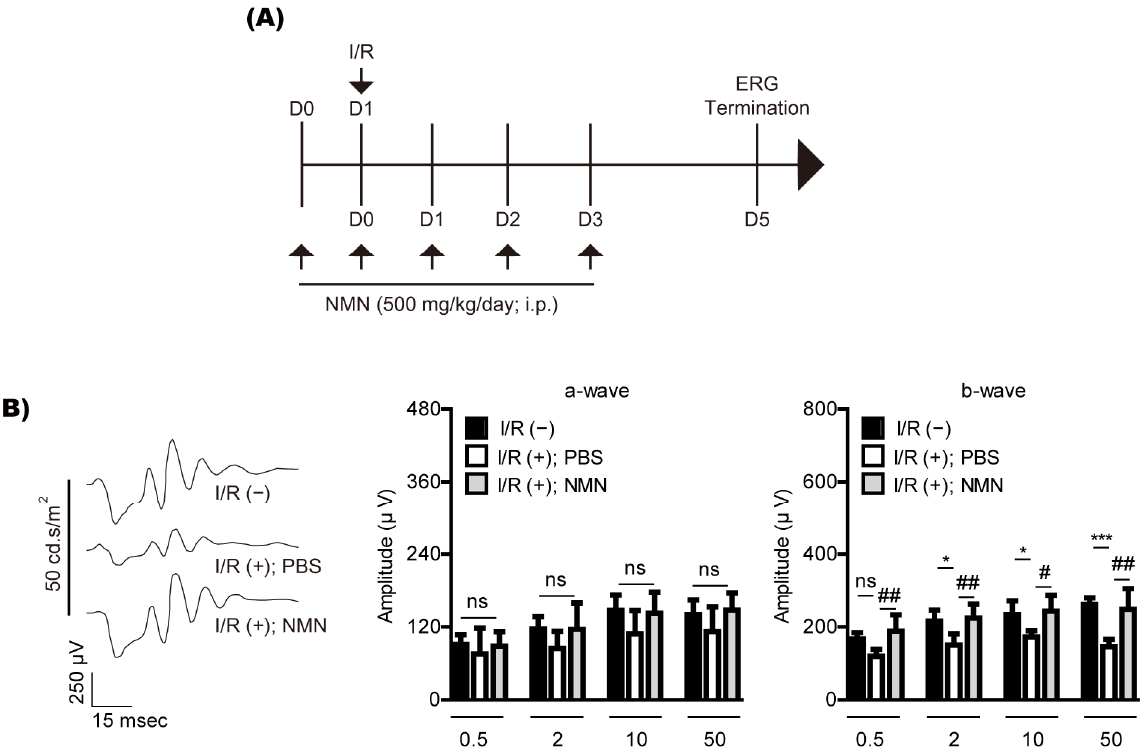
Figure 1. Retinal functional changes by nicotinamide mononucleotide (NMN) treatment in mice. ( A ) The schematic illustration shows whole experimental plans for NMN injection, retinal ischemia/reperfusion (I/R) injury, and the termination day of the whole experiment. i.p., intraperitoneal; D, day; ERG, electroretinography. ( B ) Representative waveforms (50 cd·s/m 2 ) of ERG ( n = 5–6 per group) demonstrated that the ERG amplitudes decreased 5 days after retinal I/R injury. NMN injection suppressed reductions in the ERG amplitude (especially b-wave), flashed with various intensities (0.5, 2, 10, or 50 cd·s/m 2 ). * p < 0.05, *** p < 0.001, # p < 0.05, and ## p < 0.01. ns, not significant. The data were analyzed using one-way ANOVA followed by a Bonferroni post-hoc test. The data are drawn as the mean ± standard deviation.